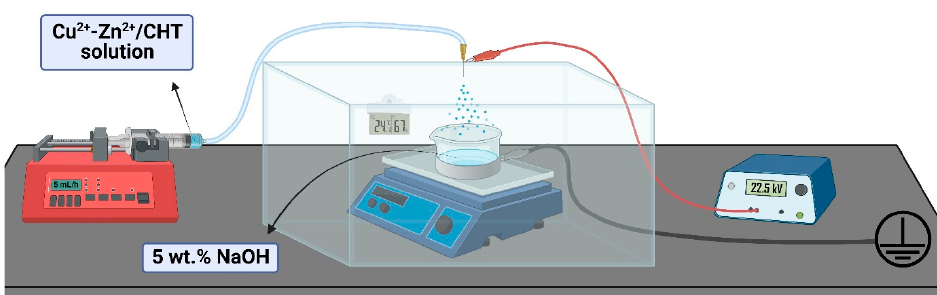
Figure 1. Schematic illustration of electrospraying setup. Created with Biorender.com.